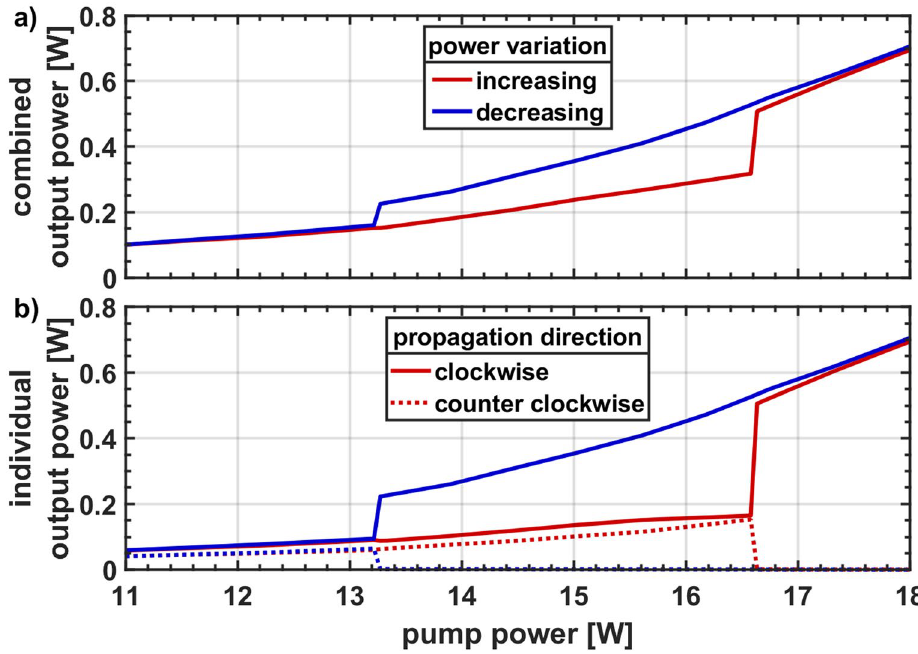
Figure 2. General evolution of ( a ) the combined output power and ( b ) the directional output powers demonstrating a bistability and unidirectional lasing